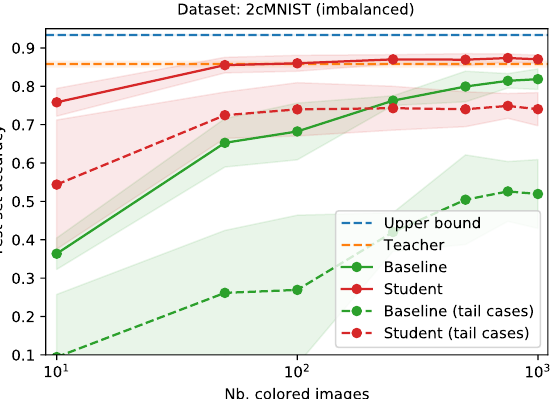
Figure 4. An overview of the available images per class, as a fraction of the total train set size. There is a slight class imbalance for the teacher ( top ), and a much heavier imbalance for the student and baseline ( bottom ).